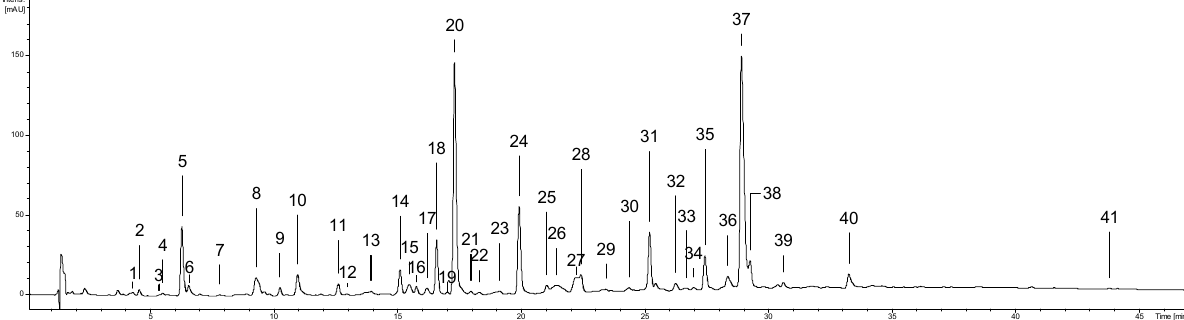
Figure 1. Representative UHPLC–PDA chromatograms of the methanol–water (75:25, v / v ) leaf extract (ME) at 280 nm. The peak numbers refer to those implemented in Supplementary Table S1.